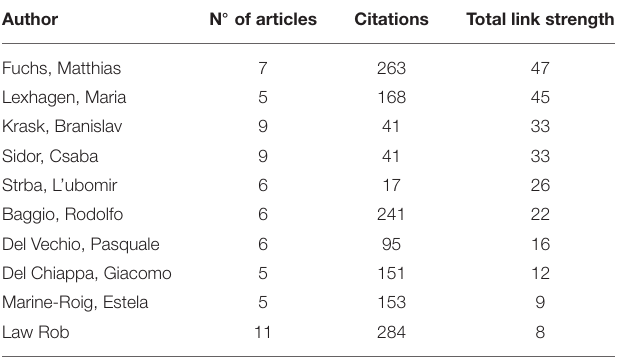
TABLE 1 | Occurrence of top 10 authors by total link strength